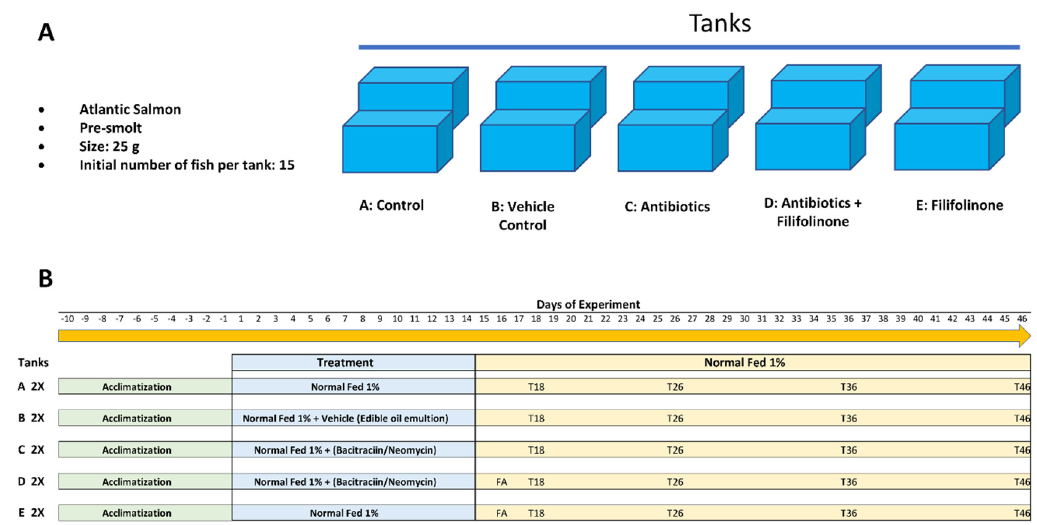
Figure 2. Experimental design. The figure shows the experimental design to test the effects on the immunostimulatory capacity of filifolinone of dysbiosis induced by nonabsorbable antibiotics. ( A ) Shows the conditions to be analyzed, the species, size, and initial number of the fish per tank. Each condition was assessed in duplicate, n = 15 per tank and n = 30 per treatment; ( B ) Shows the treatments applied per tank and the sampling kinetics. Tanks C and D were treated with nonabsorbable antibiotics for 14 days. On day 16 of experimentation, the fish from tanks D and E (FA) were injected intramuscularly with 100 ug of filifolinone. The sampling days are indicated as T18, T26, T36, and